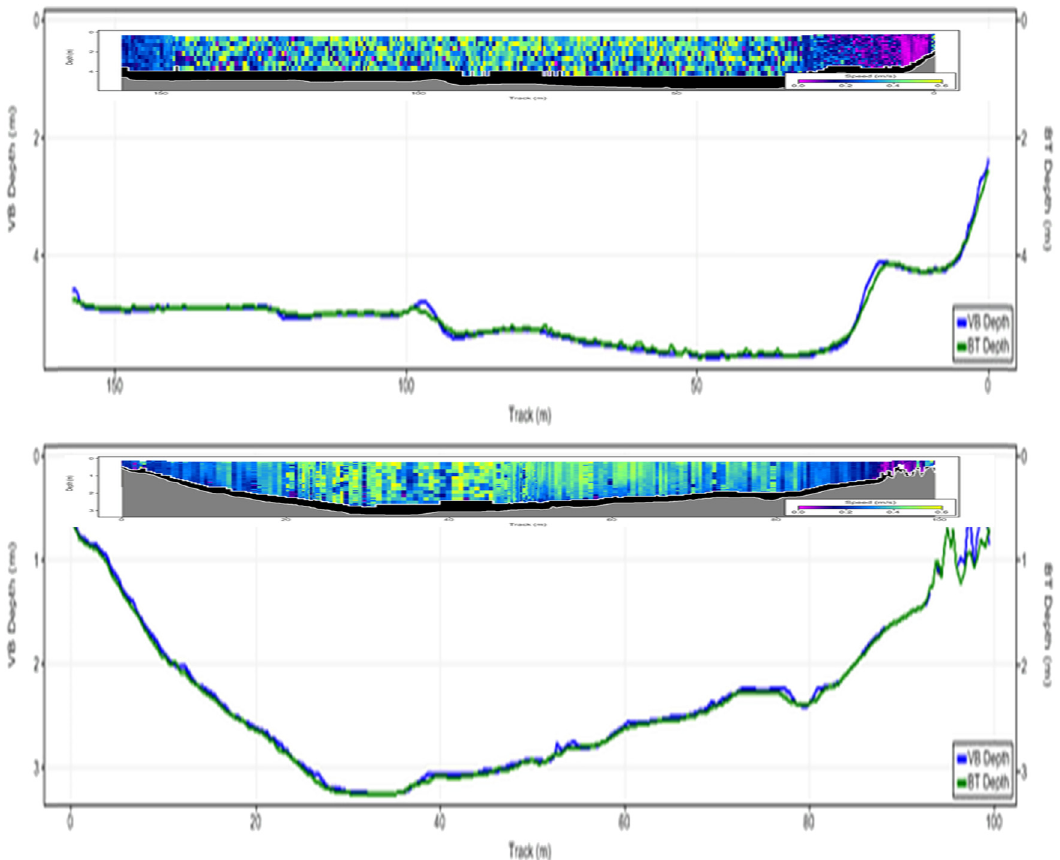
Figure 2: Cross - sections of the Euphrates river showing the widths and depths of